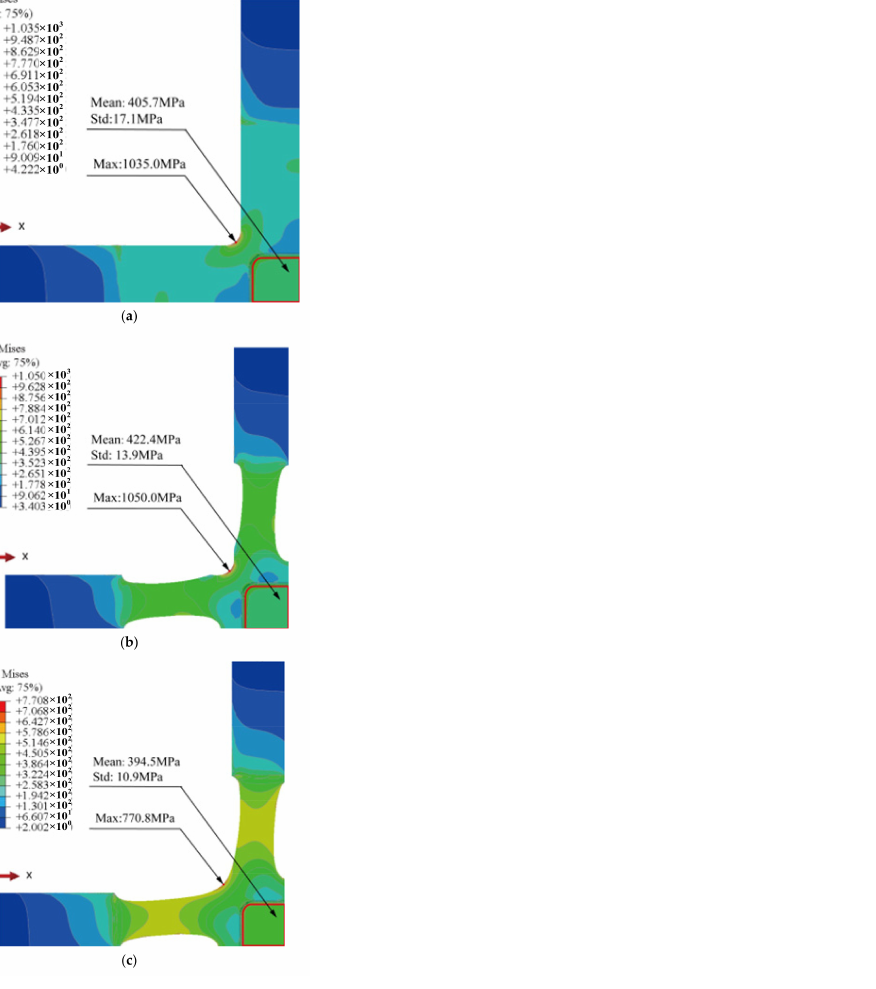
Figure 9. Stress distribution of the three specimens. ( a ) Type A: optimised specimen; ( b ) type B: specimen with only topology optimization; ( c ) type C: specimen with topology combined with shape